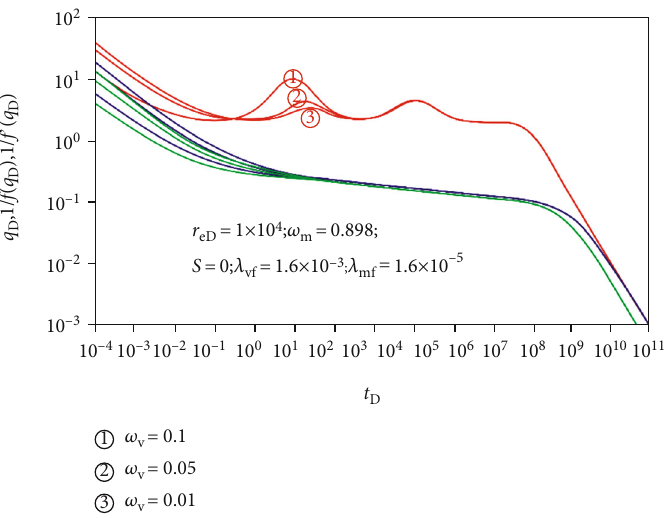
Figure 9: In fl uence of fl uid capacitance coe ffi cient of vug, ω